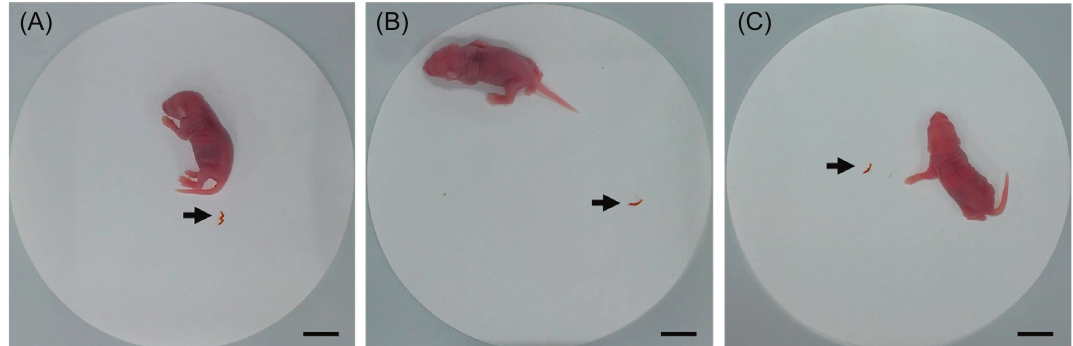
Figure 3. Bowel movements of suckling mice given PBS (A) or either dose of live spores (B and C) after 24 h of incubation at 25 (cid:3) C. Each arrow represents faeces. Scale bars = 10 mm.